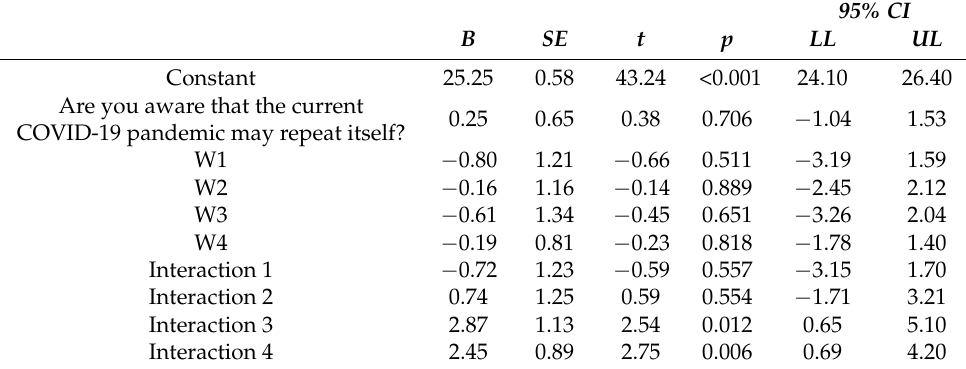
Table 5. Simple effects coefficients for the place of residence in the context of the relationship between the decision to work after graduation in nursing and stress. B SE p 95% CI Village − 0.67 0.66 0.310 − 1.98; 0.63 City up to 50,000 residents − 1.60 1.39 0.219 − 4.16; 0.96 City from 50,001 to 150,000 residents 1.14 1.06 0.283 − 0.95; 3.22 City from 150,001 to 500,000 residents 1.51 0.90 0.093 − 0.25; 3.28 City > 500,000 residents 1.75 0.52 0.001 0.73; 2.76